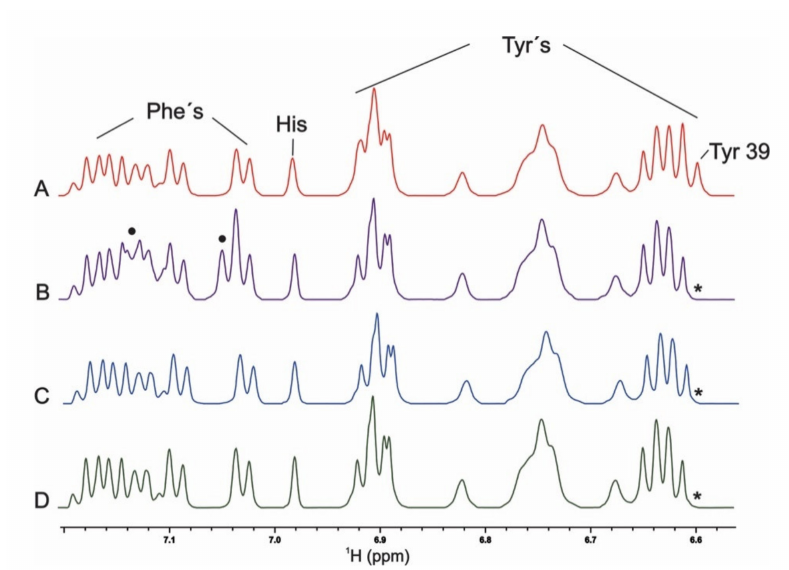
Figure 2. 1 H NMR of aromatic side chains of the position-39 α S proteins. Spectra were registered at 15 ◦ C in Bu ff er A of samples containing 100 µ M wt ( A ), Y39F ( B ), Y39A ( C ), and Y39L α S ( D ). Asterisks indicate the lack of peaks corresponding to the Tyr-39 residue. Circles indicate the detection of new signals assigned to the Phe residue in position 39.